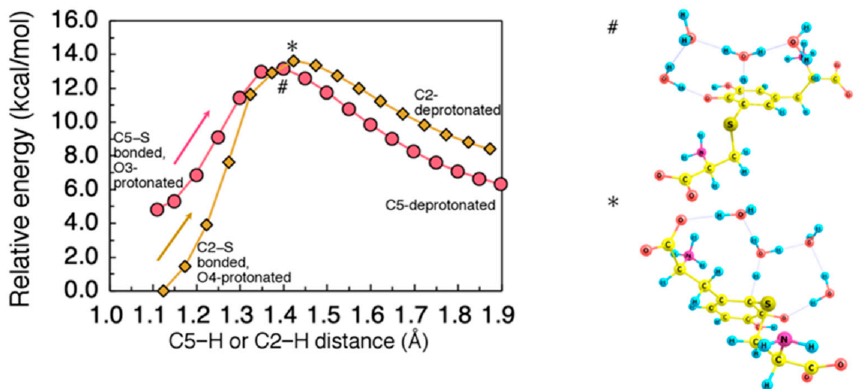
Figure 7. ( Left ) Minimum energy path for proton dissociation from C5 after − NH 3 -to-O3 proton rearrangement, and from C2 after − NH 3 -to-O4 proton rearrangement. H 2 O tetramer was used as an acceptor for dissociating proton. Energies were referenced to the total energy of the initial state structure for C2-deprotonation. All geometrical parameters except for the C5 − H or C2 − H distance were allowed to relax. ( Right ) Transition state structure for C5- (#) and C2- (*)